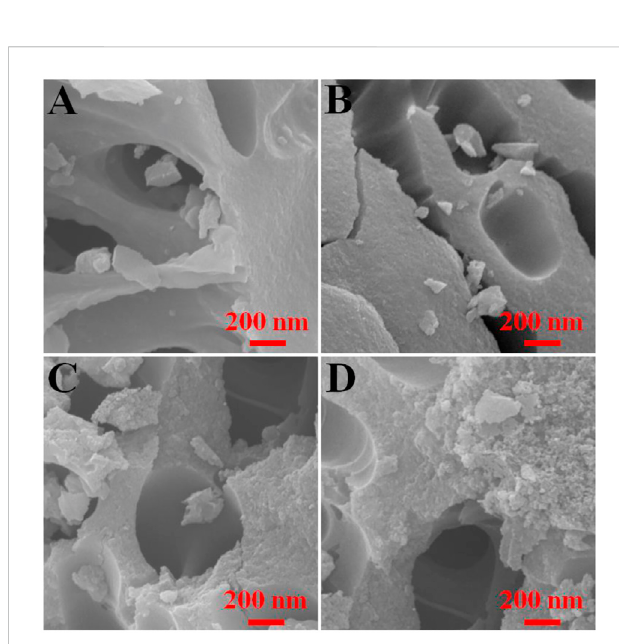
FIGURE 4 Morphology features of the typical activated carbon samples: (A) Fresh, (B) 5M-H 2 O 2 -90, (C) 10M-HNO 3 -25, (D) 10M-HNO 3